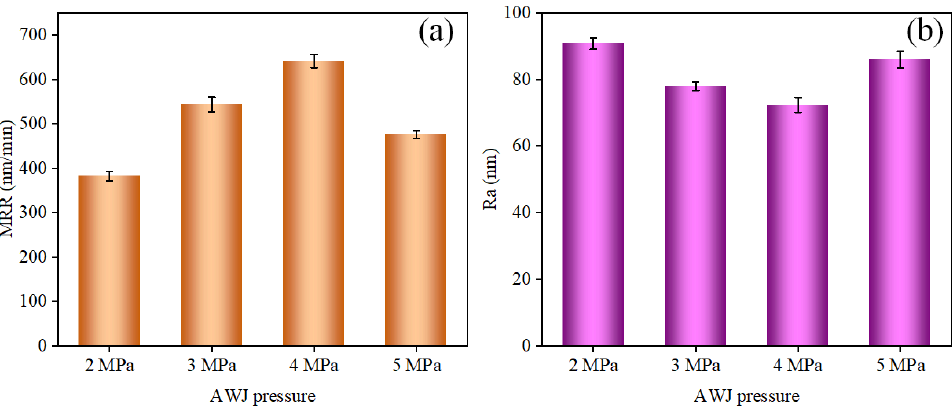
Figure 7. MRR and Ra of the FAP after dressing using AWJ with four pressures: ( a ) MRR, ( b ) Ra.